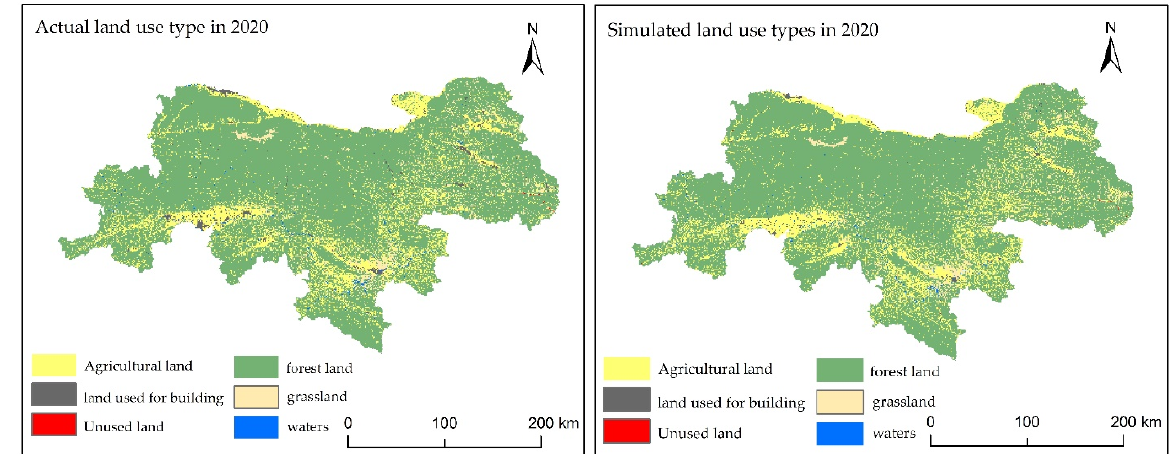
Figure 6. Actual land-use and simulation data in 2020.